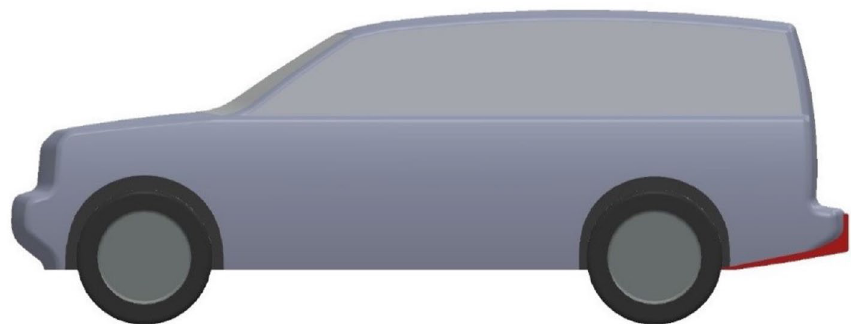
Figure 10. Side view of modified LRD4 with the spare tire.